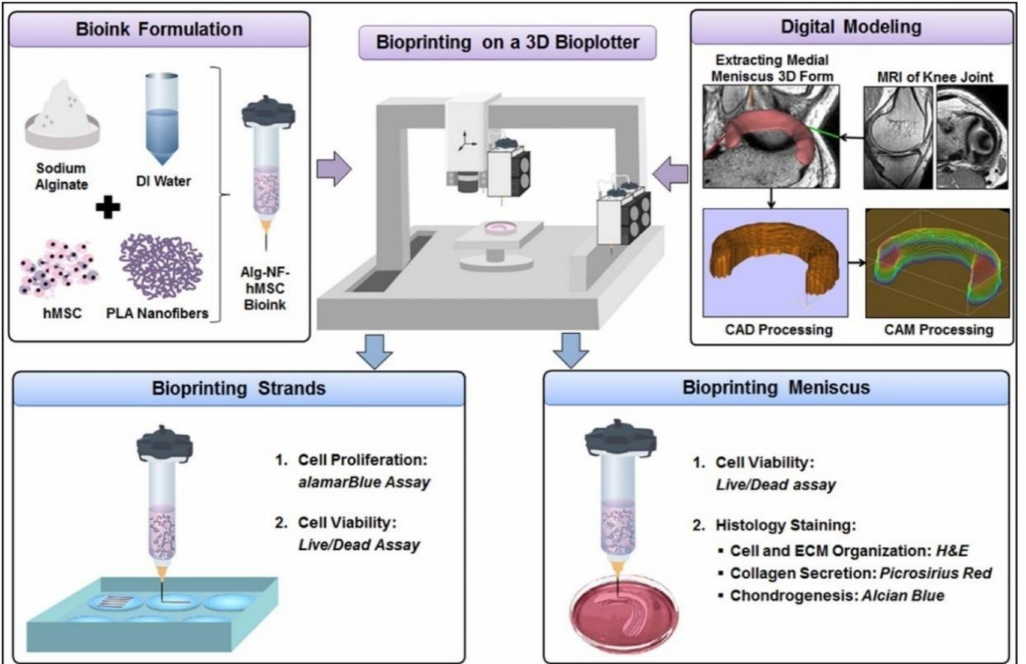
Figure 9. Overview of the procedures in the bioprinting of a PLA nanofiber-alginate hydrogel bio-ink with encapsulated human adipose-derived stem cells (hASC) (Reproduced with permission from Reference [112], copyright 2016, American Chemical